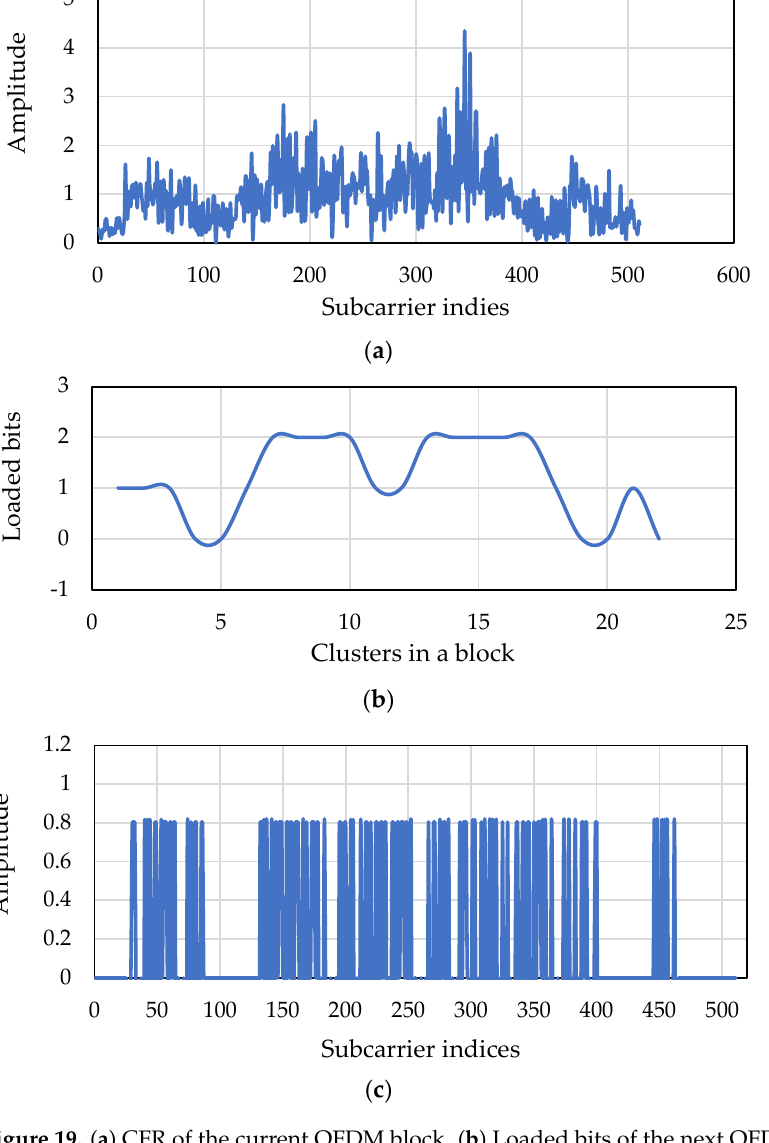
Figure 19. ( a ) CFR of the current OFDM block. ( b ) Loaded bits of the next OFDM block according to ( a ). ( c ) Power distribution for the data subcarriers of next OFDM block according to ( a ).